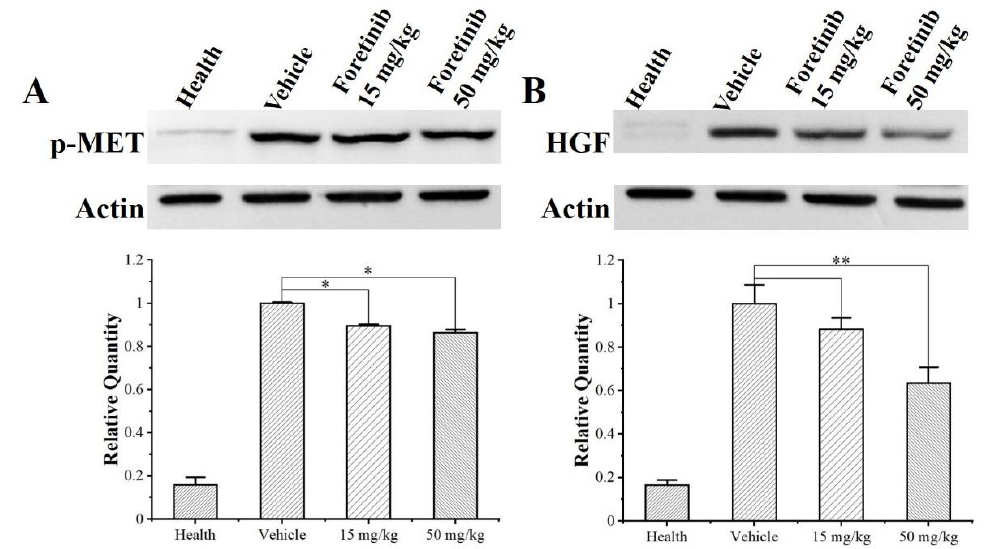
Figure 3. Foretinib inhibited p-MET and HGF in breast tissues of healthy mice and MDA-MB-231 xenograft tumor as revealed by Western blot analysis. Tumor-bearing mice were treated with foretinib (15 and 50 mg/kg) and vehicle. ( A ) Foretinib reduced the expression of p-MET in tumor tissues. ( B ) Foretinib reduced the expression of HGF in MDA-MB-231 tumor tissues. The expression of β -actin was included as a loading control for both p-MET and HGF. Each bar corresponds to the mean ± SD of three independent experiments ( n = 3). *, p < 0.05; **, p < 0.01, vehicle treatment group.